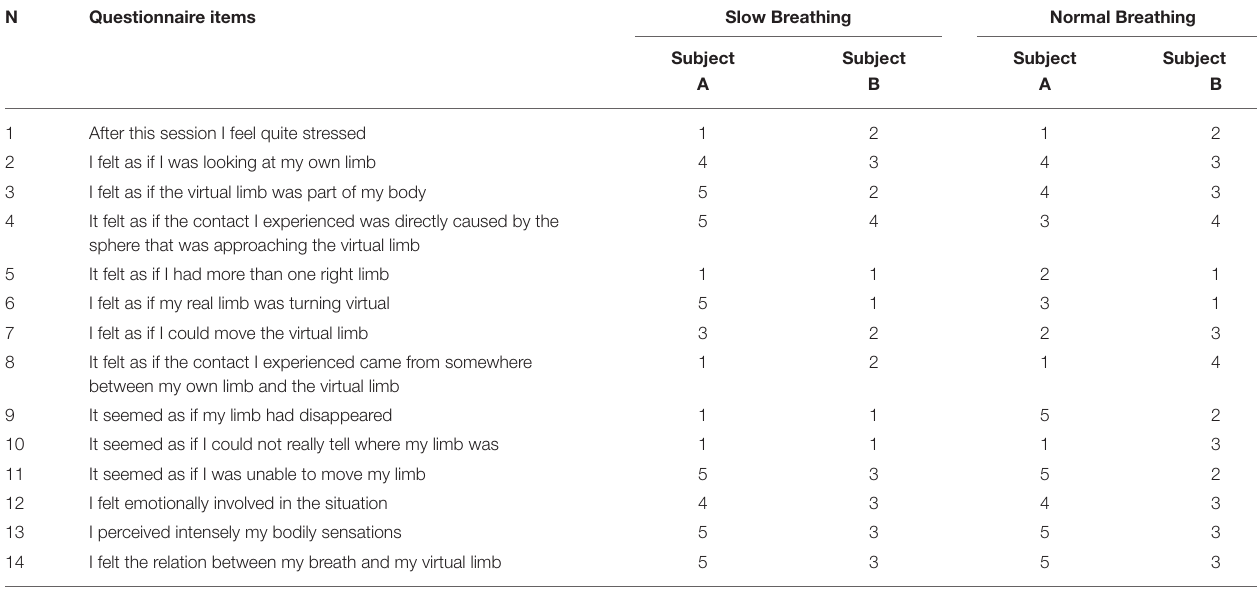
TABLE 3 | Post-trials subjective evaluation questionnaire scores reported by the two users of upper limb prostheses. N Questionnaire